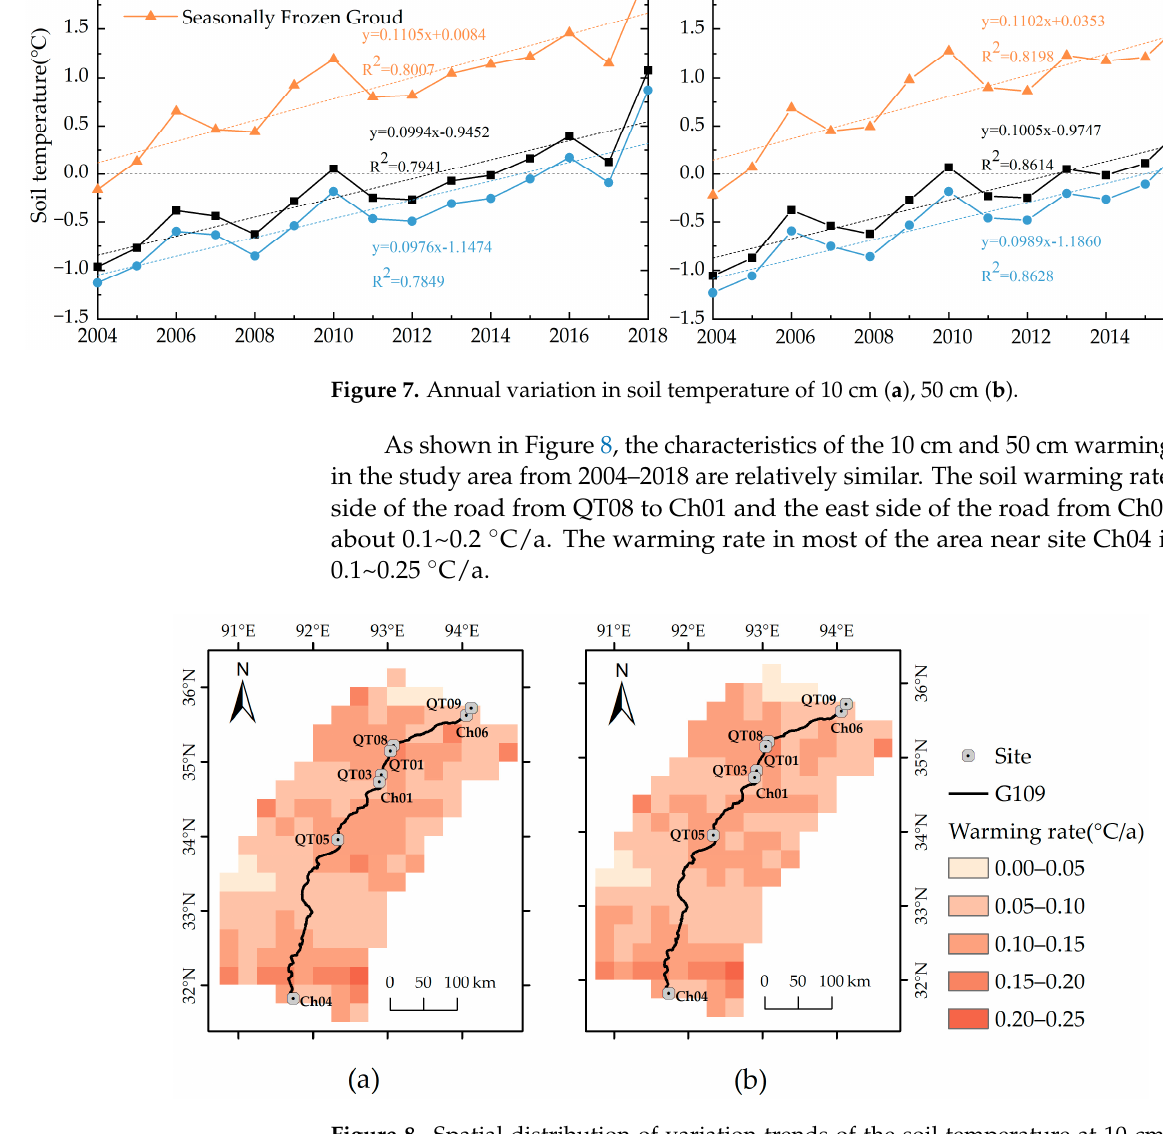
Figure 8. Spatial distribution of variation trends of the soil temperature at 10 cm ( a ) and 50 cm ( b ) over the Qinghai–Tibet engineering corridor (G109) during 2004–2018.